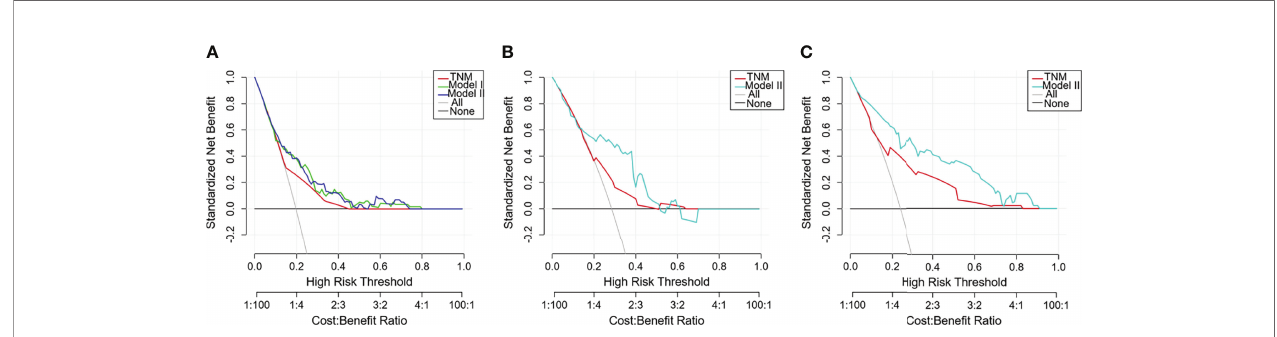
FIGURE 6 | Decision curve analysis (DCA) curves with net bene fi t score on the vertical axis and high risk thresholds on the horizontal axis for the training and validation cohorts. The net bene fi t is determined by calculating the difference between the expected bene fi t and the expected harm associated with each prediction model. The gray line denotes the assumption that all patients had outcome events (death) during follow-up. The dark black line represents the assumption that no patients had outcome events (death) during follow-up. Other curves represent different prediction models. The curve with the highest bene fi t score at that threshold is the best choice (17). (A) Training cohort; (B) TCGA validation cohort; (C) SEER